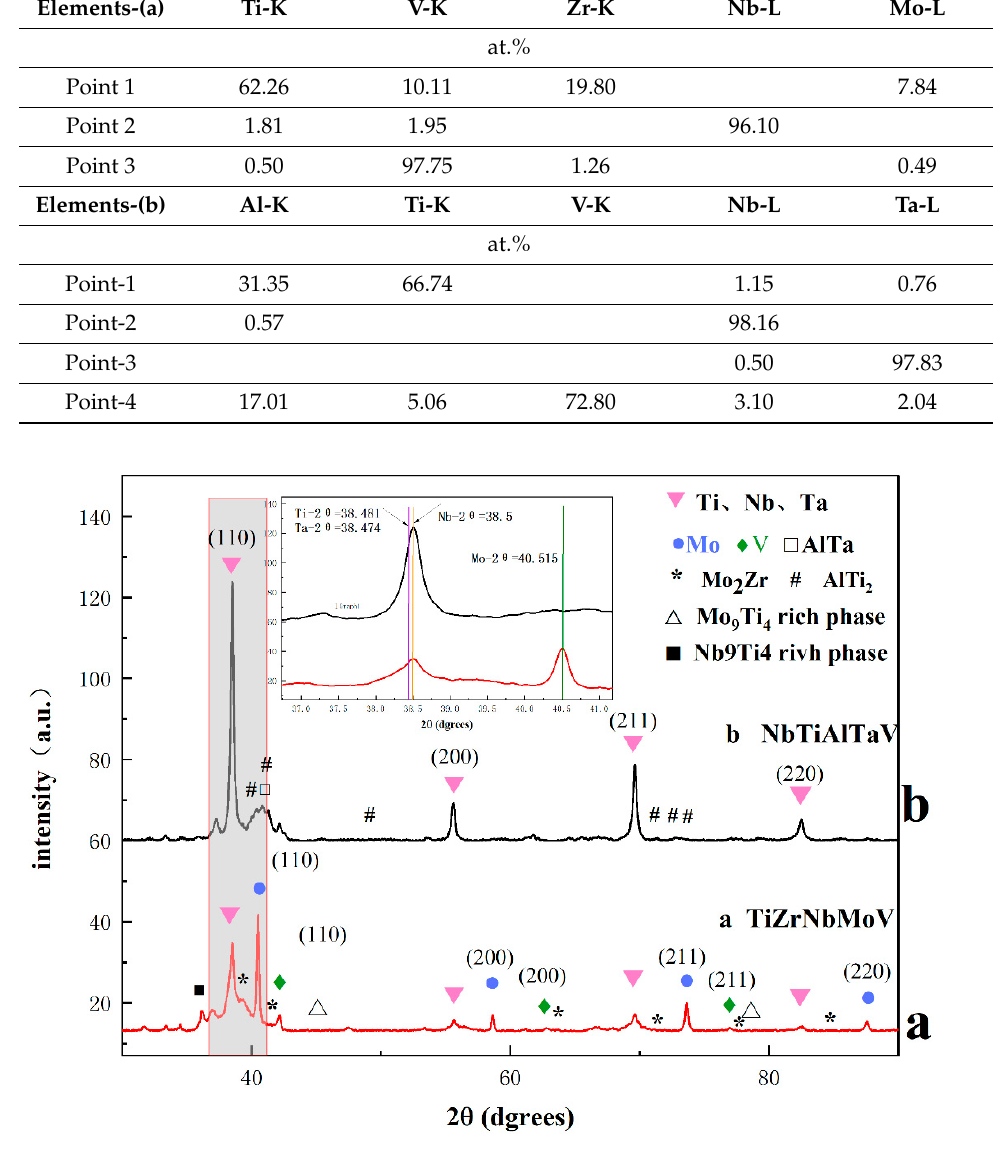
Figure 2. XRD diffraction patterns of the investigated TiZrNbMoV and NbTiAlTaV alloys synthesized, using hot-pressing sintering.